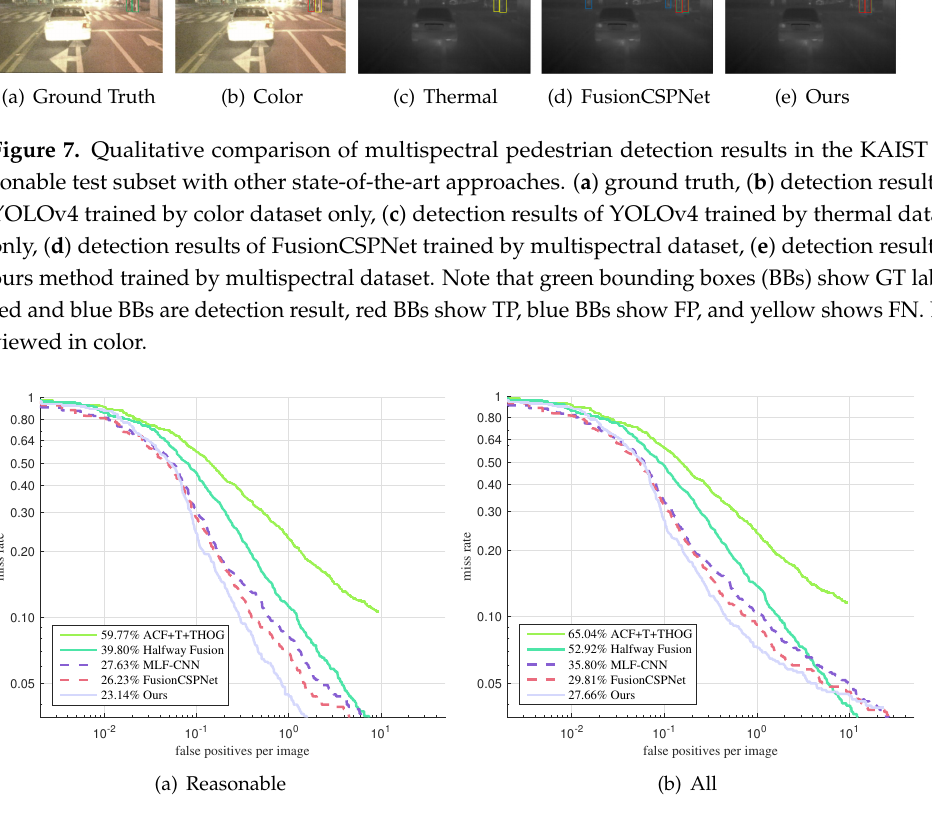
Figure 8. Comparison of the detection results reported on the test set of Utokyo. ( a ) detection results under reasonable setting, ( b ) detection results under all